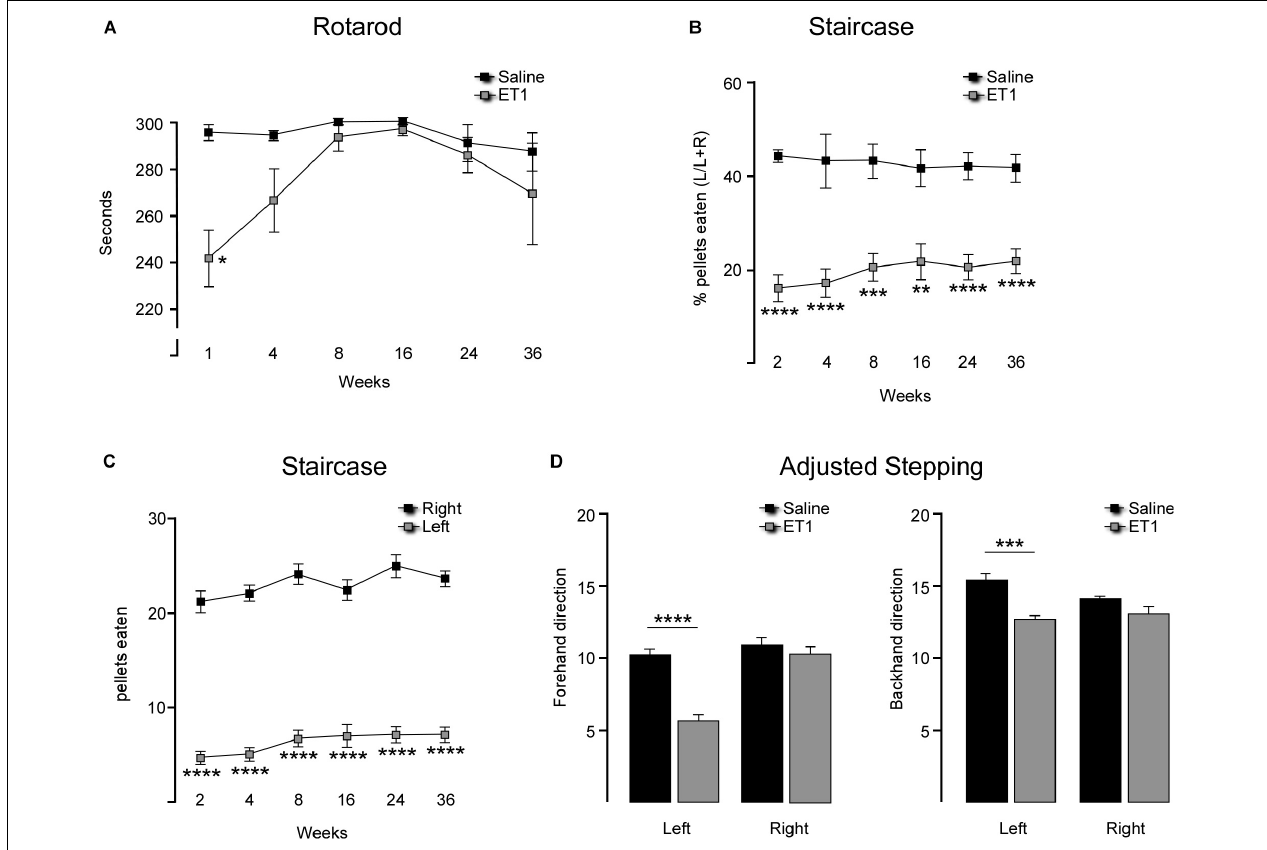
FIGURE 1 | Longitudinal comparison of motor performance in rats injected with saline or ET-1. (A) Mean latency to fall ( ± SEM) on the accelerating rotarod was significantly shorter for ET-1 treated animals ( n = 7) at 1 week but not significantly different from saline controls ( n = 6) from 4 weeks and later [two way ANOVA with Sidak’s multiple comparison: Interaction factor F 5 , 63 = 1.817, p = 0.111, Time factor F 5 , 63 = 2.536, p = 0.0373, Group factor F 1 , 63 = 10.42, p = 0.002; t (63) = 3.829; ∗∗ p < 0.0018]. (B) Successful pellet retrieval using the forelimb contralateral to the injected hemisphere (left forelimb) was significantly lower for ET-1 treated animals ( n = 18) compared to the saline controls ( n = 8) at all time-points tests up to 36 weeks (two-way ANOVA with Sidak’s multiple comparison: Interaction factor F 5 , 121 = 0.5086, p = 0.7693, Time factor F 5 , 121 = 0.1052, p = 0.9909, Group factor F 1 , 121 = 129.6; p < 0.0001; ∗∗ p = 0.0012, ∗∗∗ p < 0.001, ∗∗∗∗ p < 0.0001). (C) Total pellets retrieved with each forelimb shows a significant reduction in skilled use of the left forelimb in ET-1 animals ( n = 18) compared to the saline controls ( n = 8) at all time-points tests up to 36 weeks (two-way ANOVA with Sidak’s multiple comparison: Interaction factor F 5 , 194 = 0.3998, p = 0.8485, Time factor F 5 , 194 = 3.171, p = 0.0089, Group factor F 1 , 194 = 911.6, p < 0.0001; ∗∗∗∗ p < 0.001). (D) At the 36 week time-point, ET-1 treated animals ( n = 7) displayed a significant reduction in their capacity to make adjusted, weight-baring steps with the left forelimb compared saline controls ( n = 7) in both the backhand and forehand directions ( t -test for each forelimb; ∗∗∗ p = 0.0002; ∗∗∗∗ p < 0.0001) while there was no difference in performance for the right forelimb between treatment groups. All data shown as the group mean ±